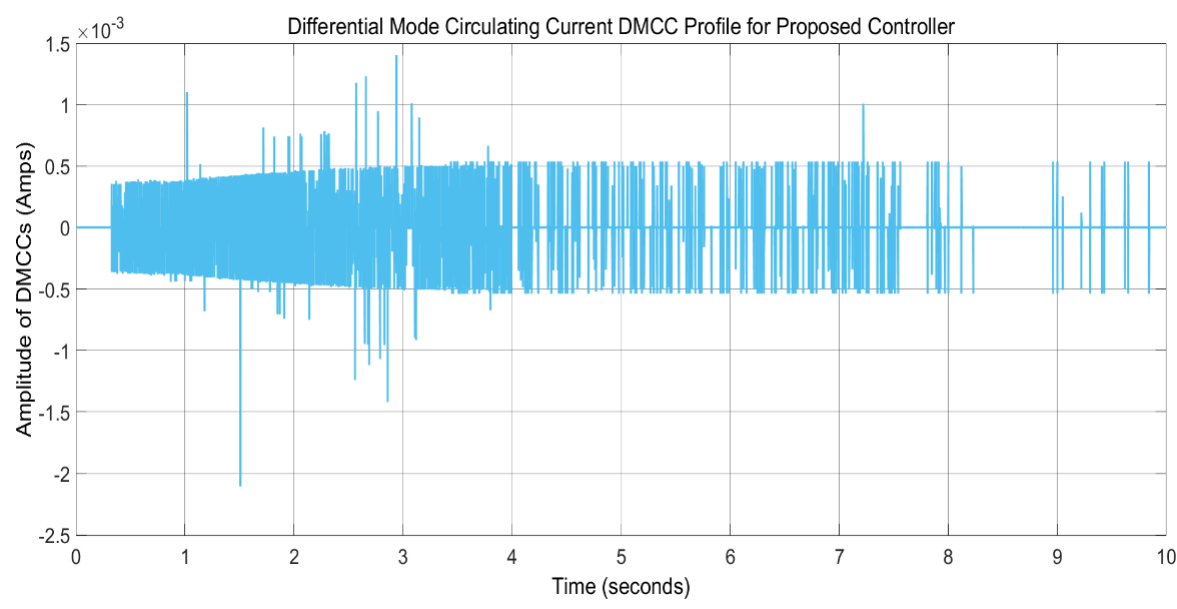
Figure 20. DMCC profile for two converters with inductor currents with proposed controller.